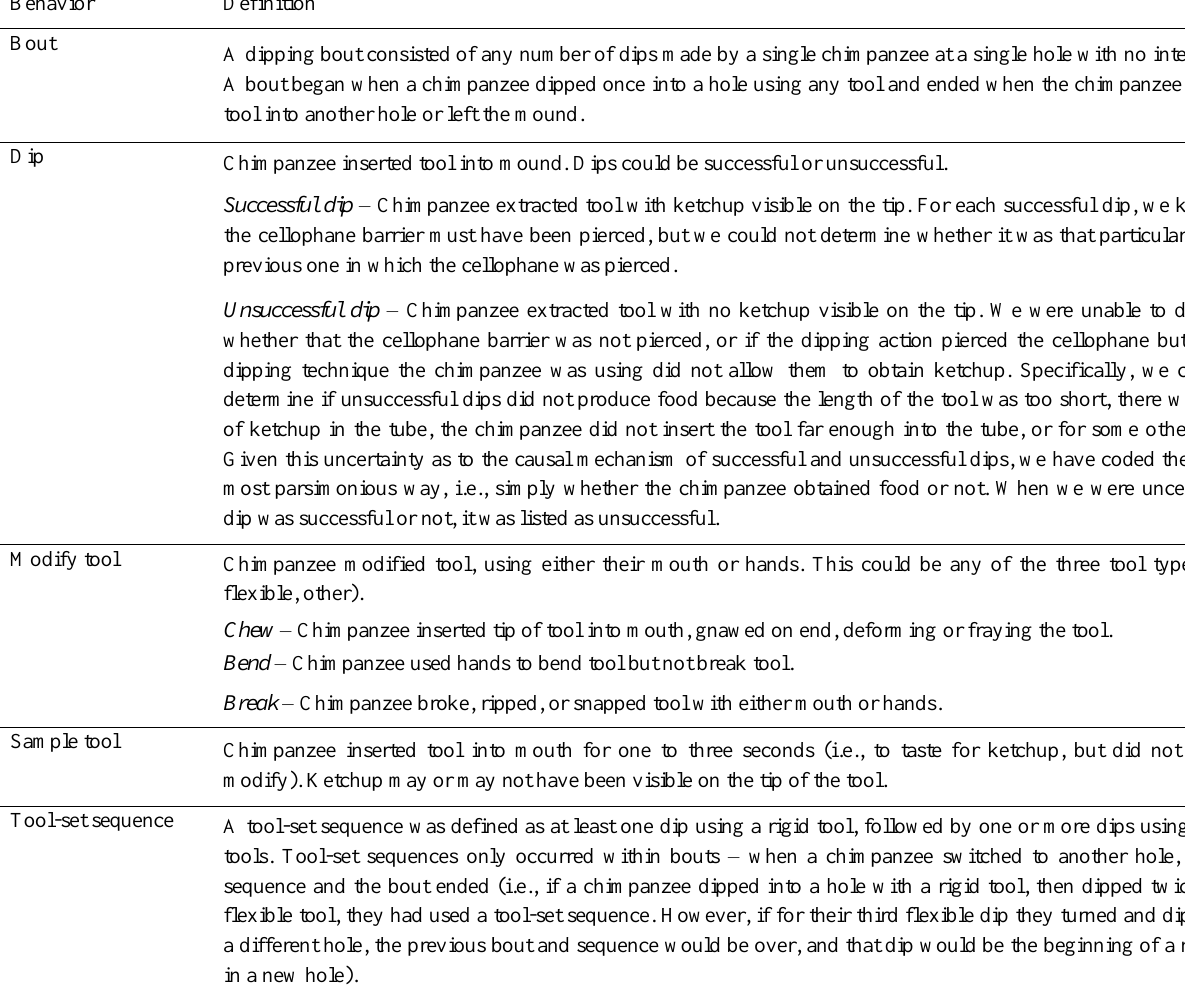
Operational Definitions of Coded